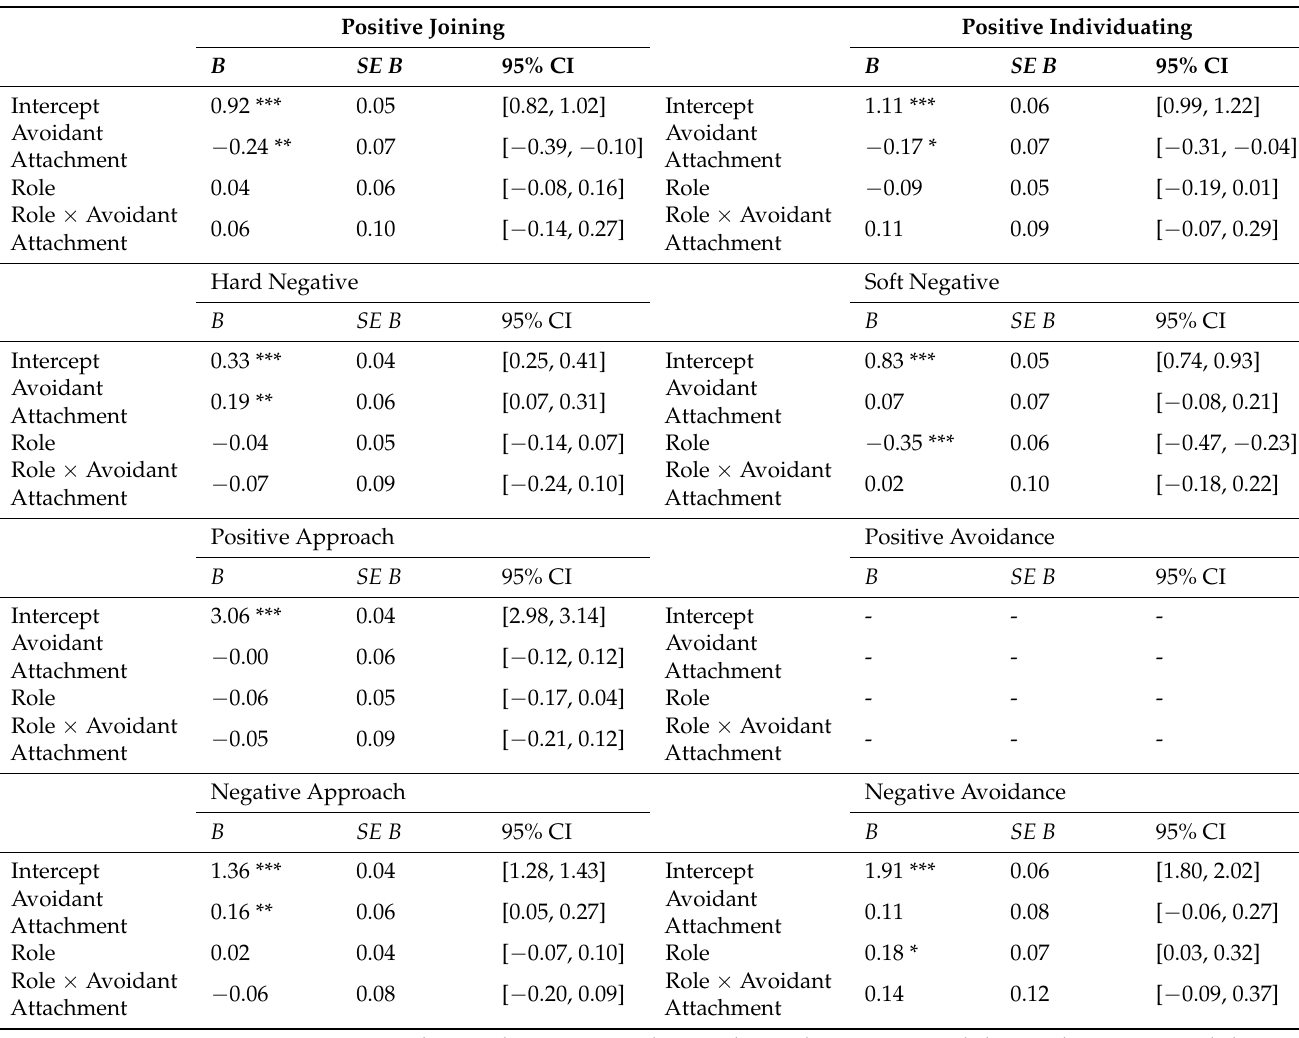
Table 4. Two-level mixed effect models of avoidant attachment, affective expression, and communi- cation behavior for patients and